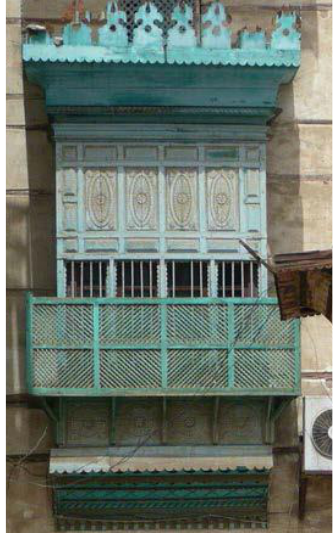
Figure 2. Example of the